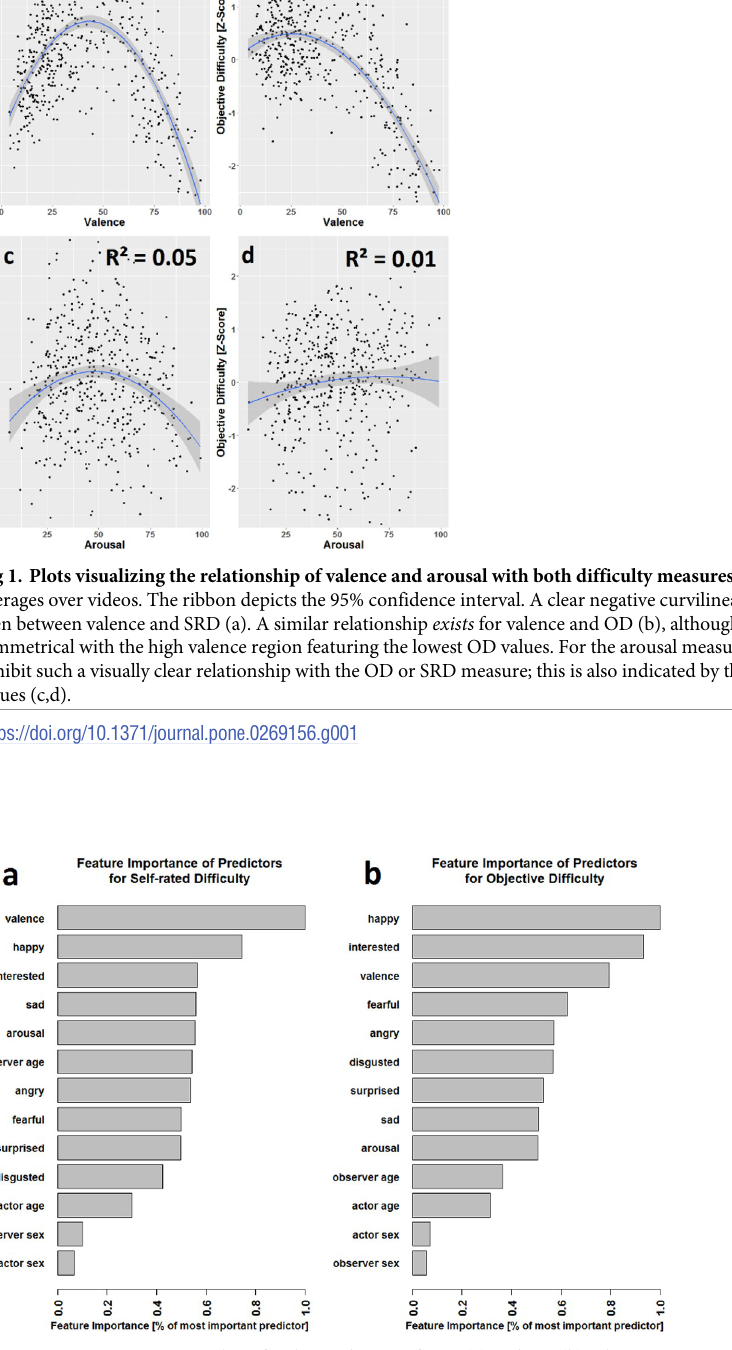
Fig 2. Feature importance ranking for the prediction of SRD (a) and OD (b). The importance is expressed as a proportion of the importance of the strongest predictor and displayed in decreasing order from top to bottom. For the SRD measure the valence and happy ratings show a high importance, while all of the observer- and actor-specific variables except observer age show a particular low importance. For the OD measure the happy rating is the most important predictor with the interest and valence ratings following up close in importance.